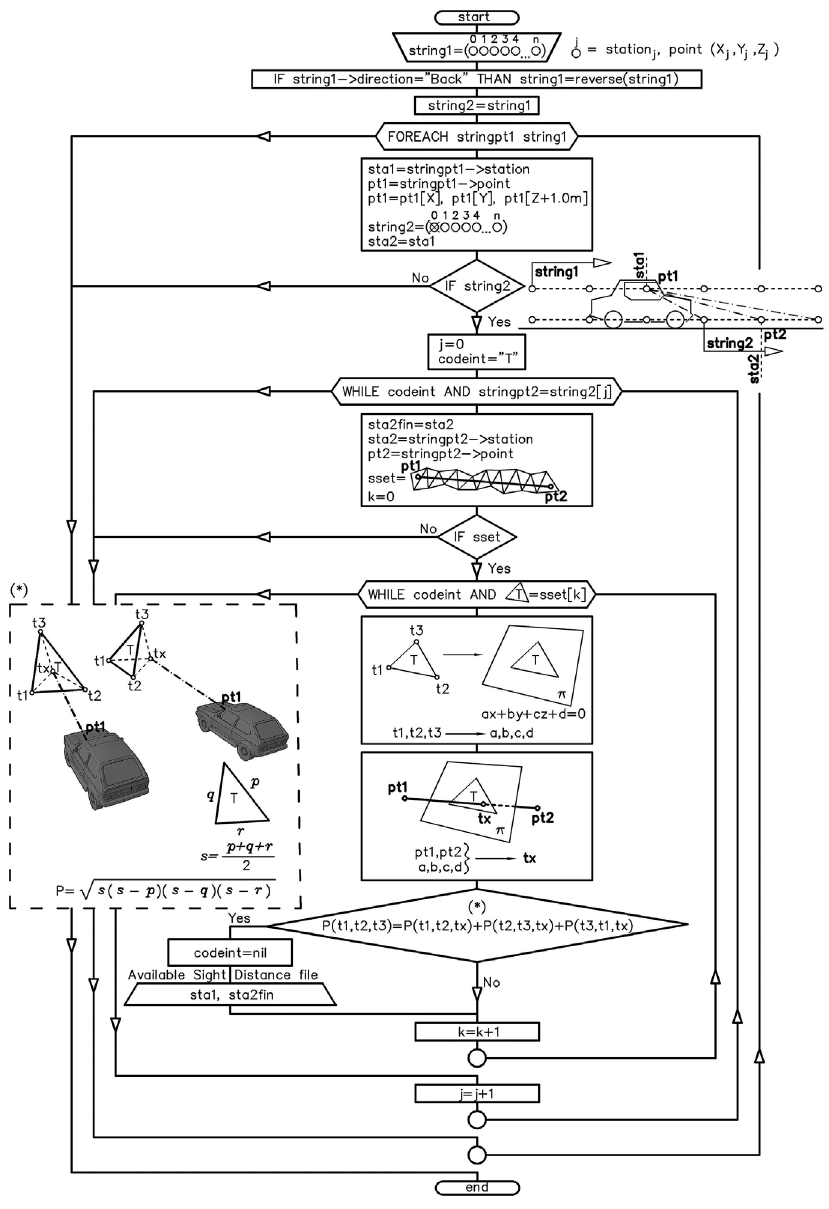
Fig. 11. Algorithm for calculating ASD from the triangulated 3D